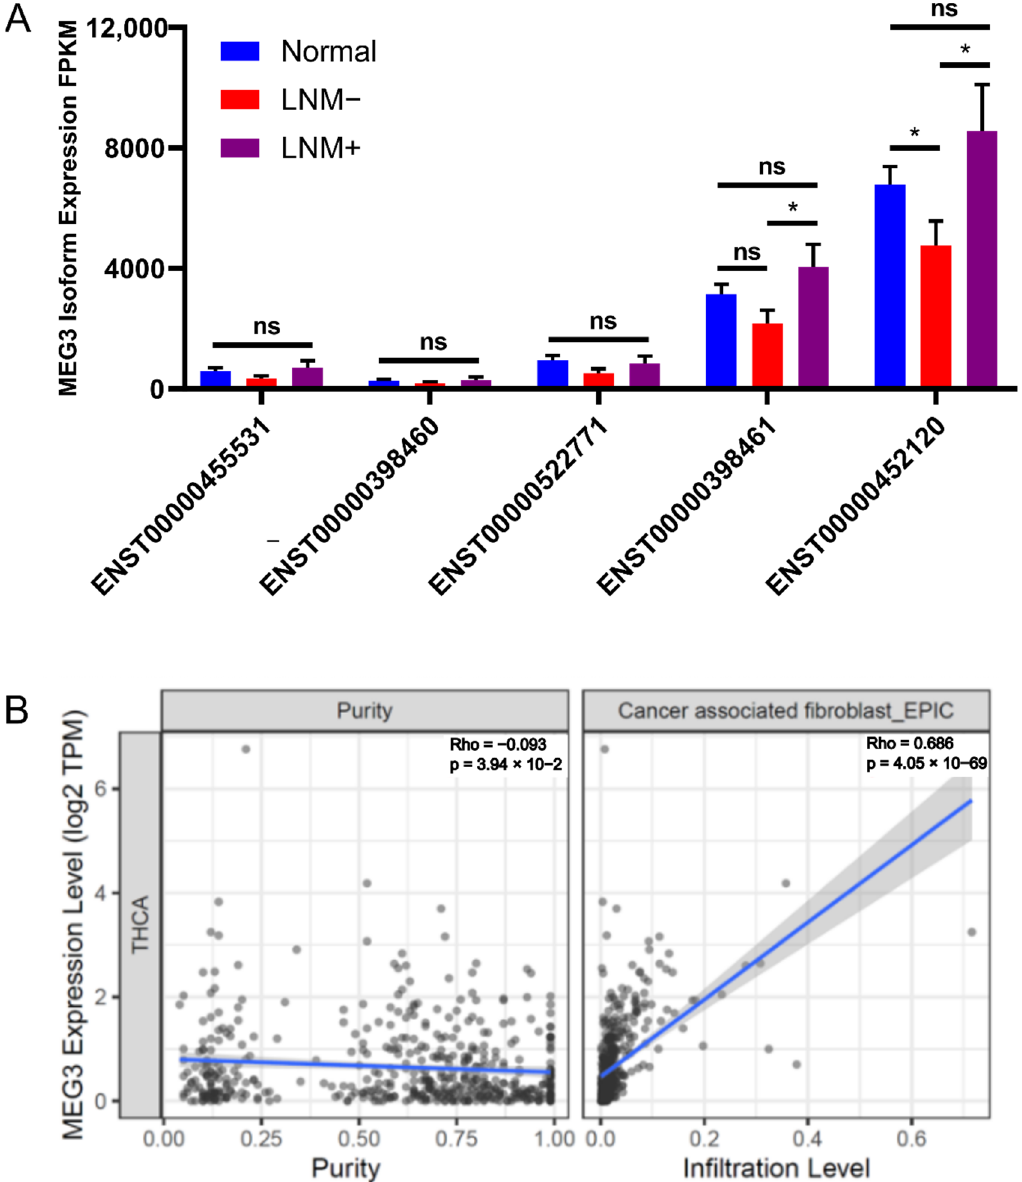
Figure 4. MEG3 isoform expression and association with infiltration of CAFs. ( A ) MEG3 transcript isoform usage in normal (non-cancerous) tissue and NYMC PTC (LNM+/ − ). ( B ) Scatter plots demonstrating the correlation of MEG3 expression in TCGA THCA project with tumor purity and estimated infiltration level of CAFs using TIMER2.0. EPIC output was used to represent fibroblast infiltration estimates from TIMER2.0. * p < 0.05; ns, non-significant